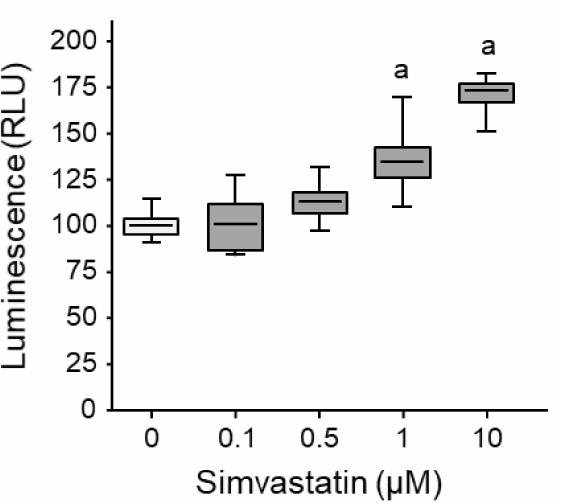
Figure 1. Statin-induced osteosarcoma cell membrane permeability. Murine osteosarcoma cells K7M2 were loaded with calcein-AM (5 %M) for 2 h, then exposed to increasing concentrations of simvastatin for 16 h. Calcein release during plasmolysis induced by a hyperosmotic solution was determined. Box plot illustrating the global relative luminescence units (RLU). Lower, middle, and top lines of boxes indicate lower quartile, median, and upper quartile, respectively. Whiskers indicate minima and maxima. a: p < 0.002 compared to solvent.